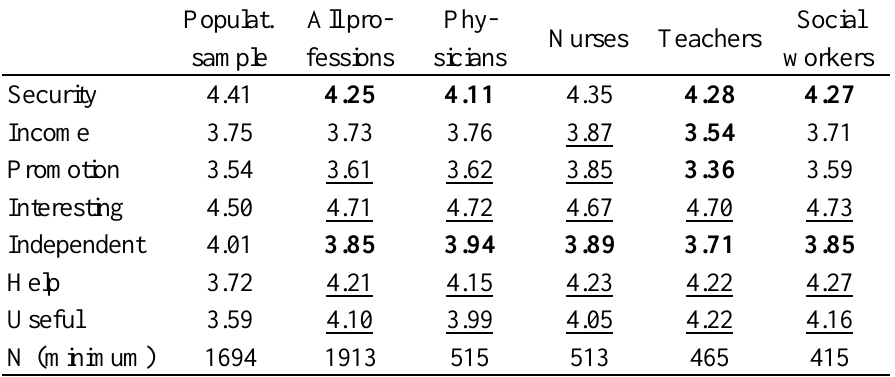
Table 1. Direct ratings of the importance of job characteristics. Group specific arithmetic